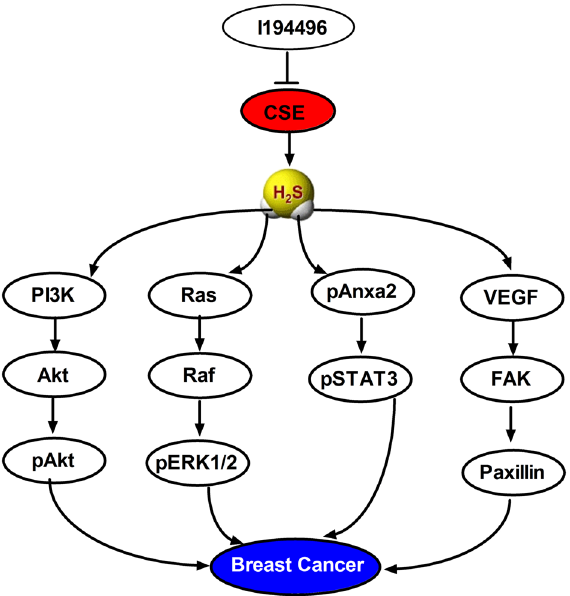
Figure 9. Schematic diagram of the mechanism underlying the inhibitory effects of I194496 on the progression of TNBC. Blunted arrows indicate